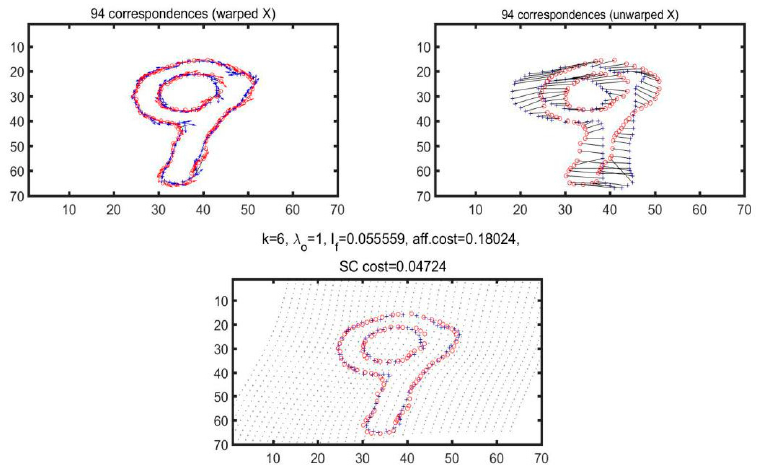
Figure 7. Matching results of handwritten numbers ‘9’.